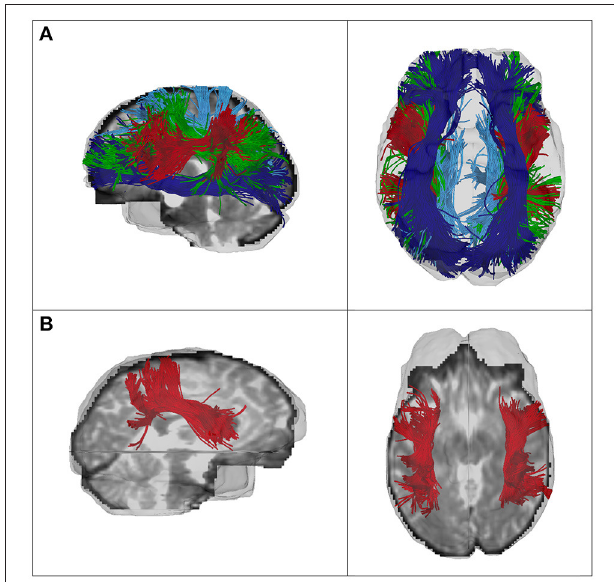
FIGURE 1 | (A) Fiber clustering results of the SLF-I (light blue), SLF-II (green), SLF-III (red), and SOFF (dark blue) of one CHR female, and (B) of the SLF-III of one HC female. Left column, sagittal view; right column, axial